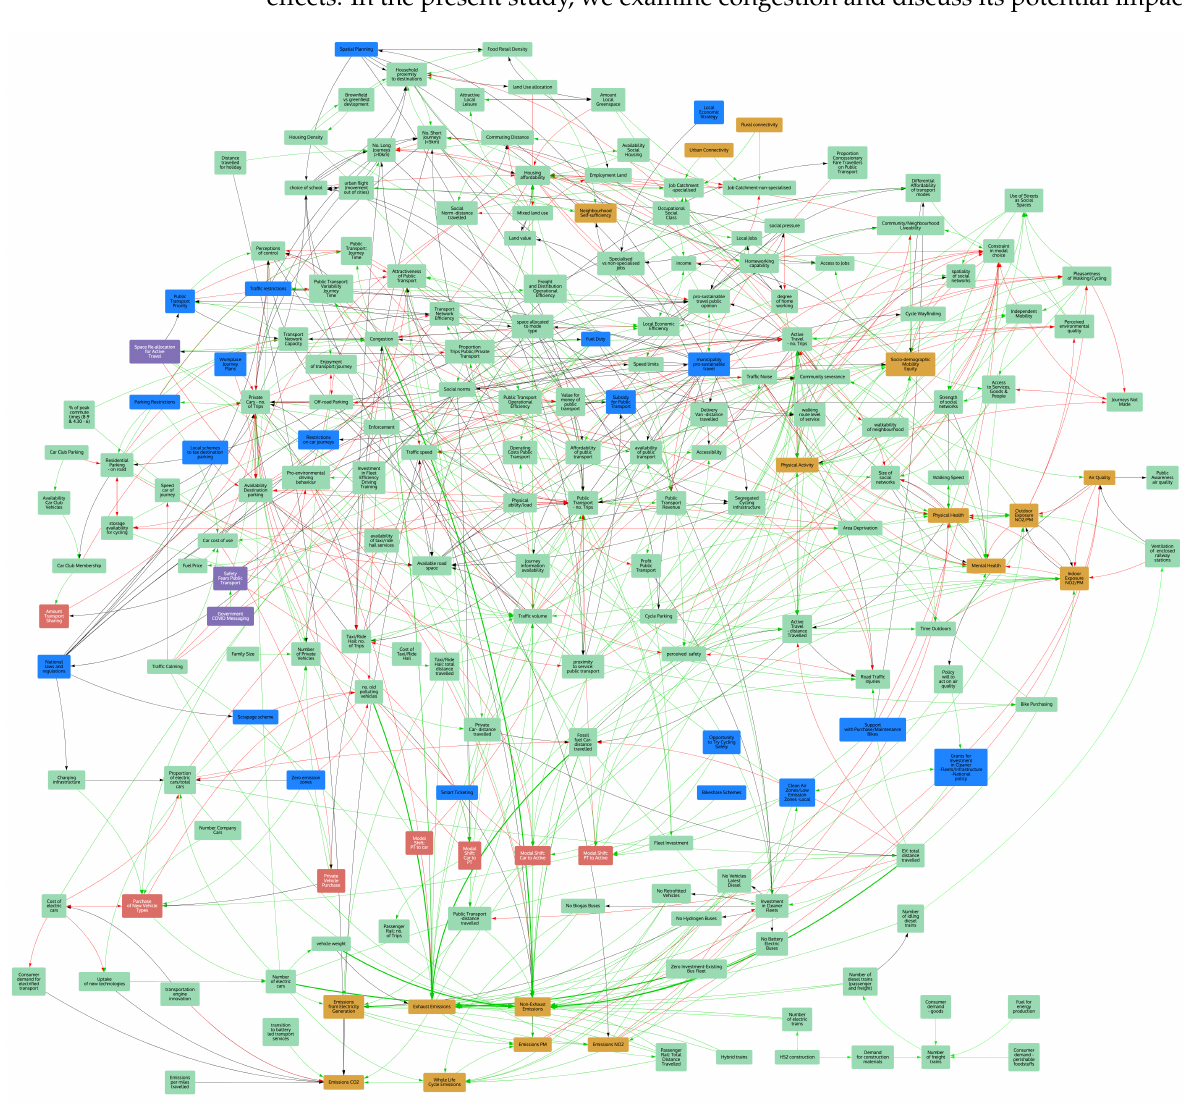
Figure 1. Full systems map of the U.K. surface transport system generated within the case